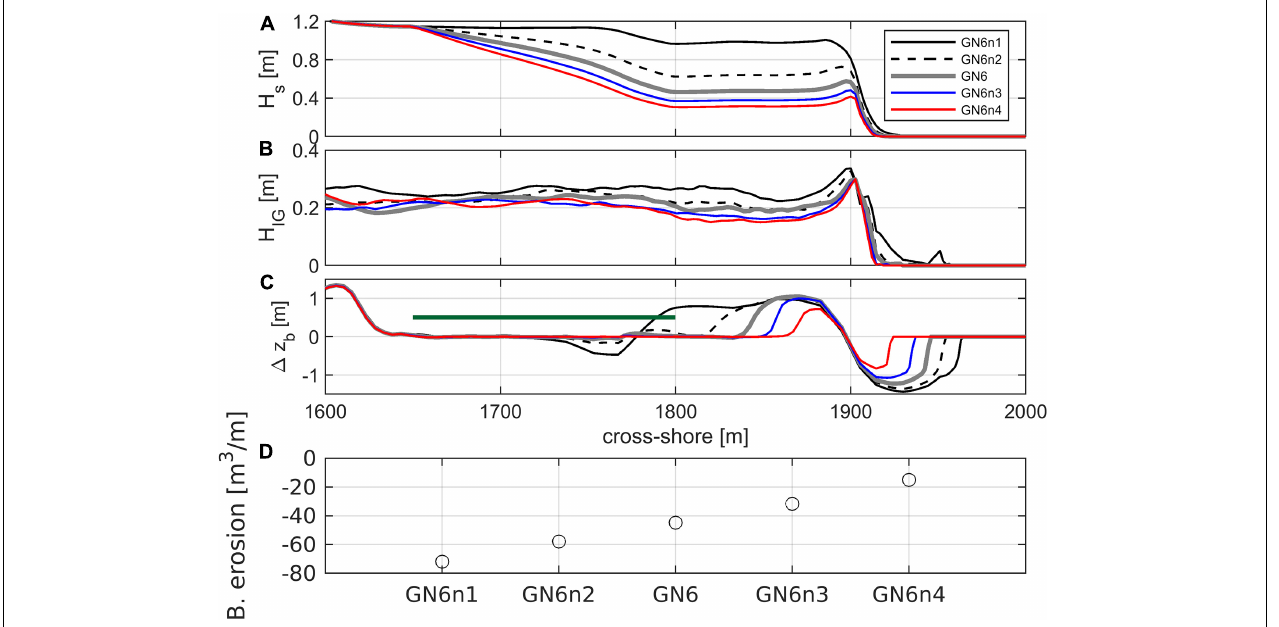
FIGURE 12 | Sensitivity to seagrass shoot density, showing: (A) wave height distribution; (B) infragravity wave distribution; (C) seabed change; and (D) beach erosion.